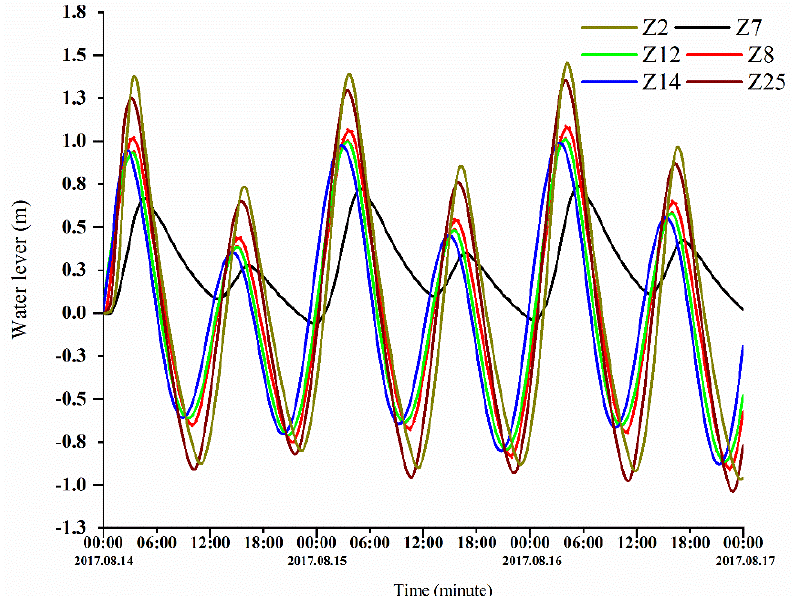
Figure 11. The sea level time series during the three days at different stations in